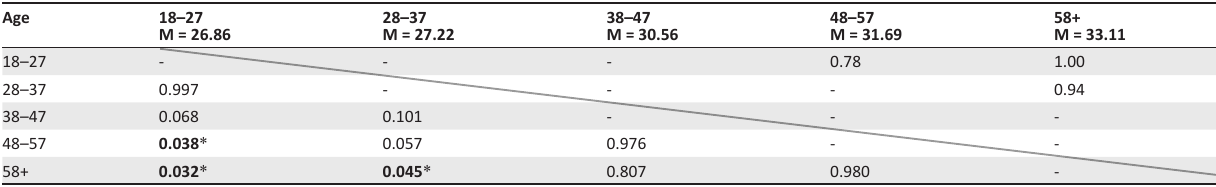
TABLE 7: Tukey tests and Cohen’s d for dedication , according to age.